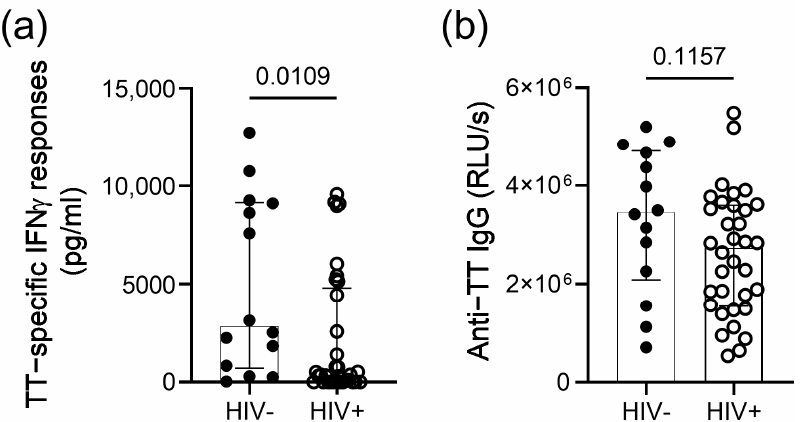
Figure 1. TT-specific IFN γ responses and antibody levels among the HIV-infected and HIV-uninfected study participants. ( a ) IFN γ concentrations in the supernatant 3 days after stimulation with TT protein in persons with self-reported prior vaccination. Background responses (unstimulated condition) are subtracted for each participant. ( b ) Plasma levels of the anti-TT IgG antibodies in persons with self- reported prior vaccination. Medians, interquartile ranges and p -values of the comparison between groups using the Mann–Whitney test are presented.